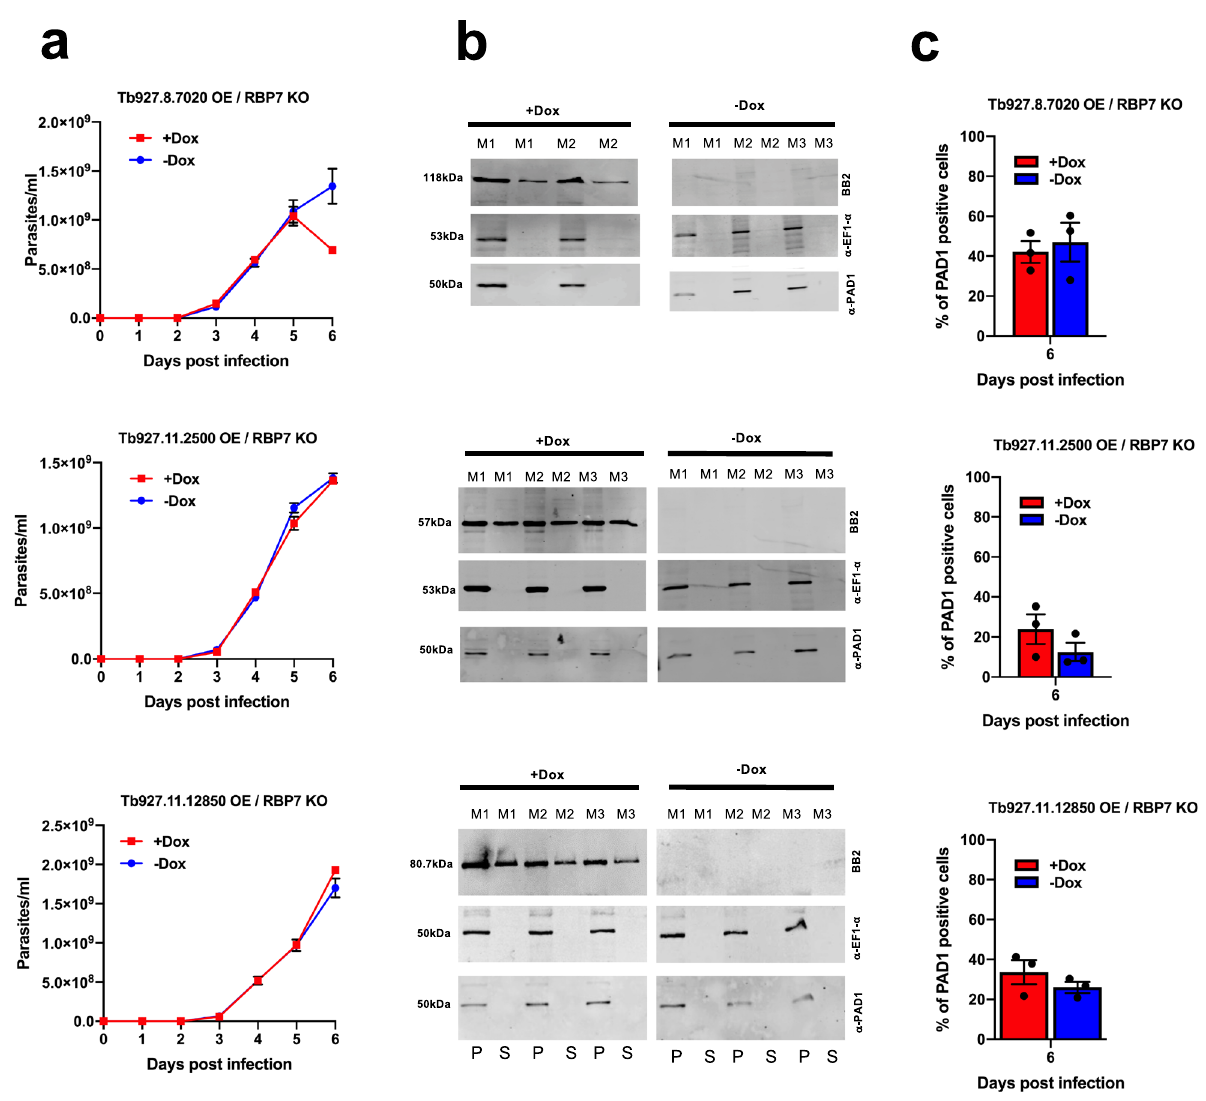
Fig. 4 Accelerated differentiation activated by the expression of three peptidases is mediated via the QS signalling pathway. a Infection pro fi le for mice infected with parasite lines ectopically expressing each peptidase (Tb927.11.2500, Tb927.11.12850 or Tb927.8.7020) under doxycycline regulation with the QS signalling pathway disrupted ( Δ RBP7A/RBP7B). In each case, six mice were infected (biologically independent samples), with three being provided with doxycycline to induce ectopic peptidase expression (uninduced, blue; induced, red). In all cases, the parasitaemia (mean ± SEM) progressed unchecked due to the lack of transduction of the QS signal caused by deletion of RBP7A/B. b Con fi rmation of the inducible expression and extracellular release of each peptidase in an Δ RBPA/B background. Parasites were harvested from the infections shown in a , with three mice being induced for ectopic peptidase expression and three being uninduced as biologically independent samples. Detection of the stumpy marker PAD1 demonstrated equivalent stumpy generation in the parasites regardless of the inducible expression of the peptidase. Stringent doxycycline-regulated expression is observed in each case. The loading control for the cell pellet was EF1-alpha. Parasites were not successfully puri fi ed from one of the mice in the + Dox group at the end of the experiment due to a failure with the DEAE resin. c Quantitation of PAD1 expression on day 6 post infection when parastaemias exceeded 1 × 10 9 /ml. PAD1 immuno fl uorescence assays were based on three biologically independent infection pro fi les represented in a and analysed by western blotting represented in b . Source data are provided as a source data fi